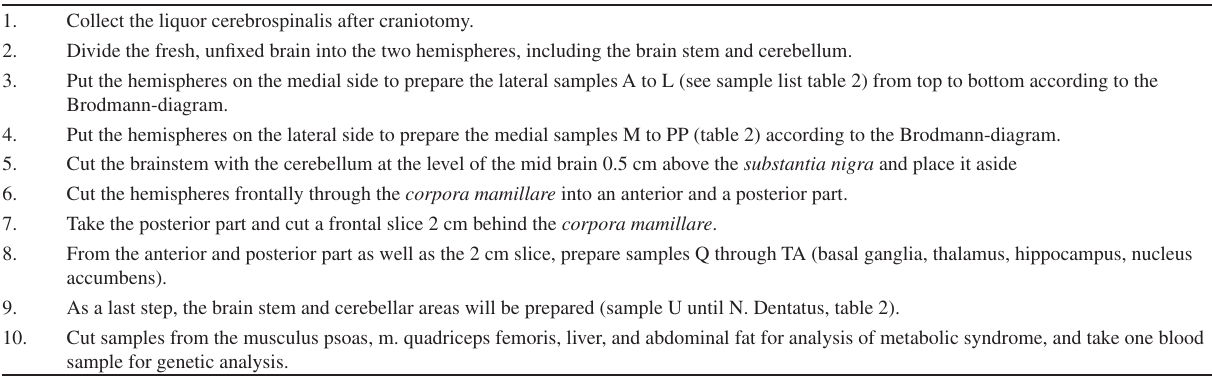
Table 1 - Neuroanatomical preparation protocol in Brain Net Europe II, brain bank of psychiatric diseases, Göttingen